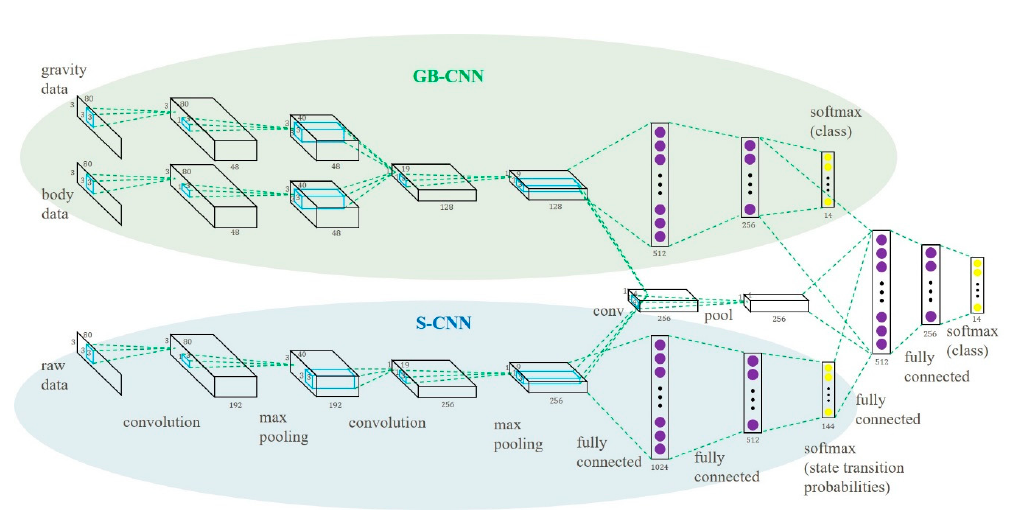
Figure 3. Multipath CNN model.